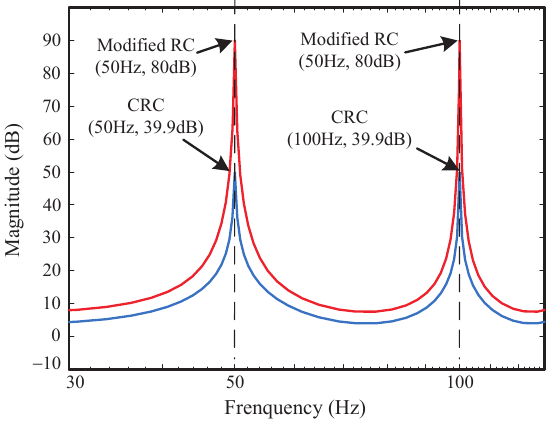
Figure 5. Bode diagram of modified RC and CRC.